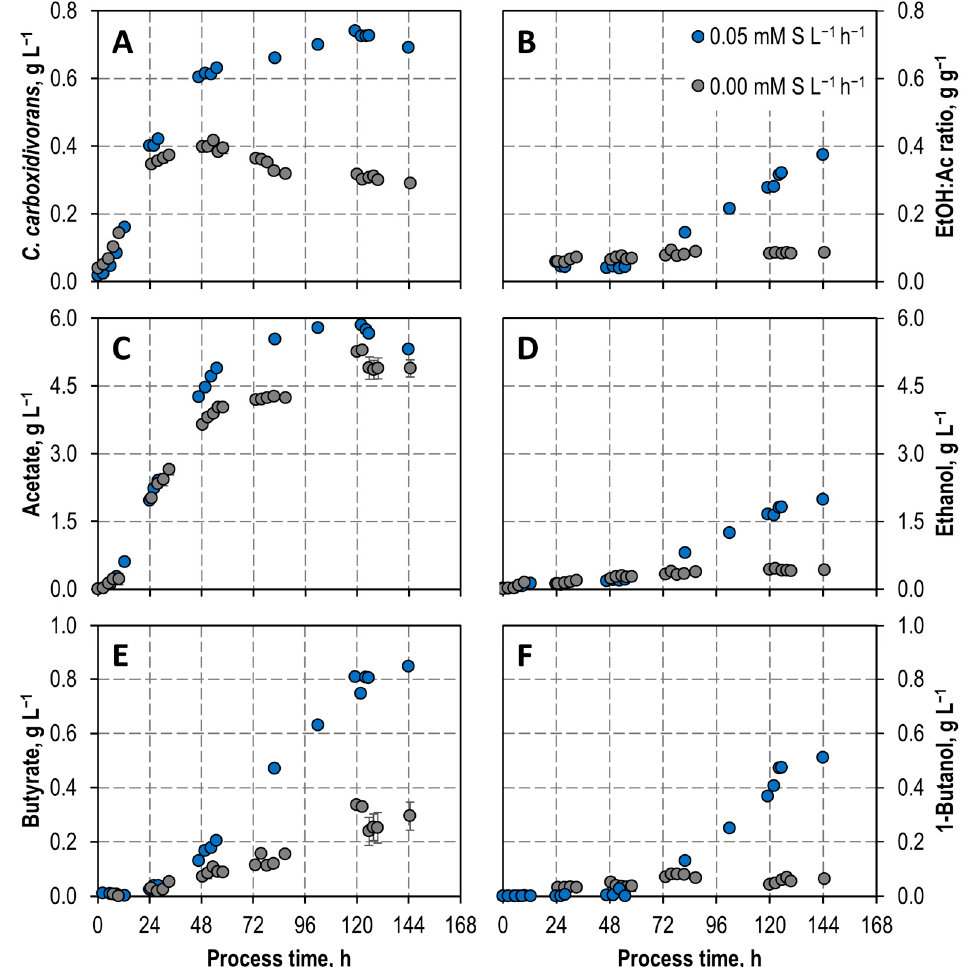
Figure 4. Autotrophic batch cultivations of C. carboxidivorans in continuously gassed, fully controlled stirred-tank bioreactors (T = 37 °C; pH = 6.0; P V − 1 = 10.5 W L − 1 ; 200 mbar CO 2 ) with an initial CO partial pressure p CO,in = 100 mbar at F gas = 0.042 vvm without continuous sulfide supply (grey) compared to the same autotrophic batch process with continuous sulfide supply of 0.05 mM S L − 1 h − 1 (blue). ( A ) Cell dry weight concentrations (CDW) of C. carboxidivorans ; ( B ) ethanol: acetate ratio; ( C ) acetate concentrations; ( D ) ethanol concentrations; ( E ) butyrate concentrations; ( F ) butanol